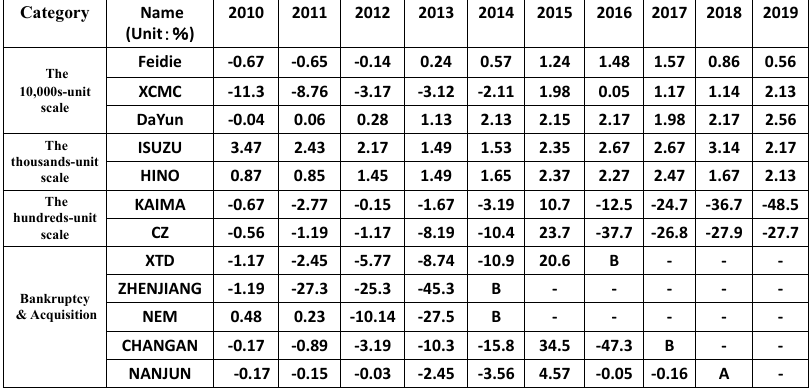
Table 2. The profit rate of Chinese commercial vehicle makers (2010– 2019)